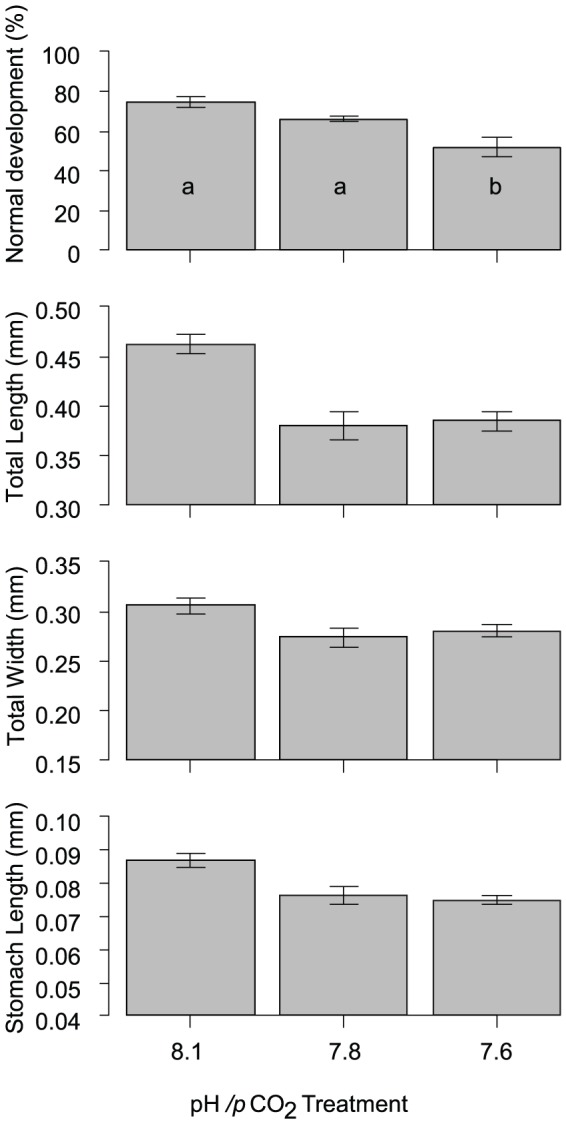
Percentage of normal development and several morphometric parameters for Acanthaster planci larvae grown for 10 d under control and two reduced pH/increased pCO2 conditions.Error bars represent 1 standard error. Averages with different letters are significantly different (p<0.05, Tukey-Kramer posthoc tests).